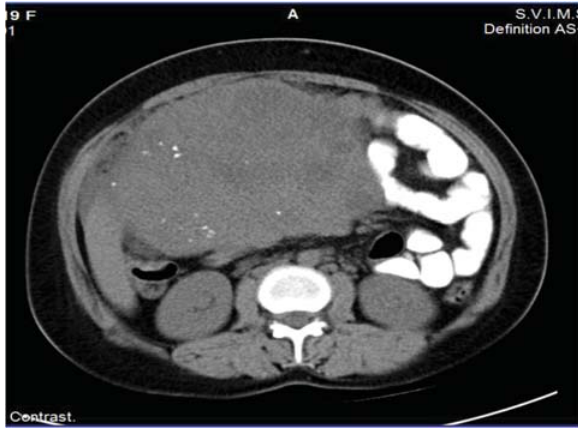
Figure 1. CT scan of abdomen-well de fi ned heterogeneously enhancing mixed density lesion with calci fi cation in pelvis and abdomen Minimal free fl uid was present. Small lymph nodes were noted in perigastric region measuring1.8X1.5 cms. Gonads could not be visualized separately. While off estrogen therapy her gonadotropins were grossly elevated [FSH -110IU/L) and LH 40 IU/L) respectively], consistent with hypergonadotropic hypogonadism. Her karyotyping was 46XY.